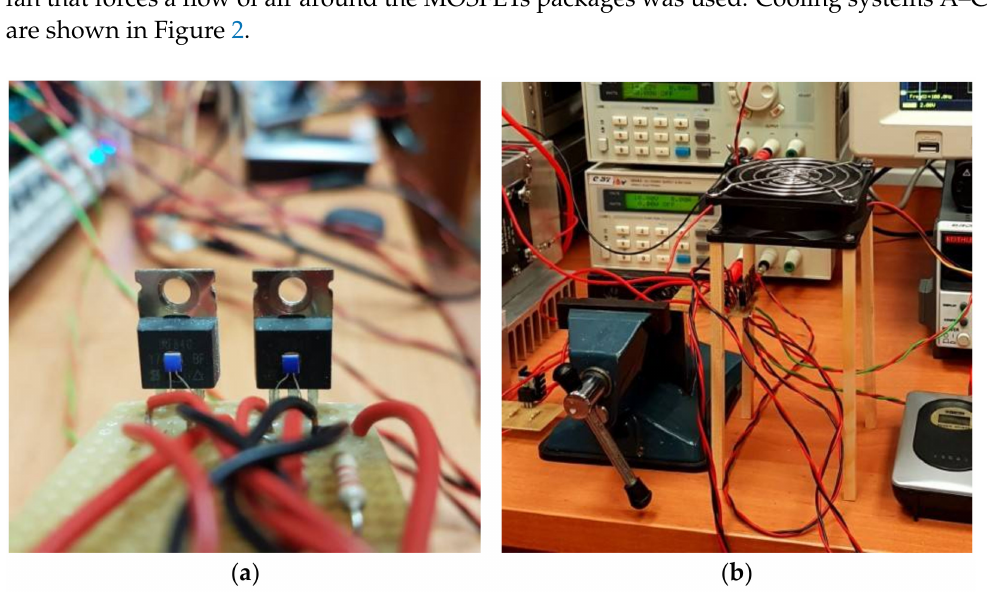
Figure 2. Cooling systems ( a ) A and ( b ) B and